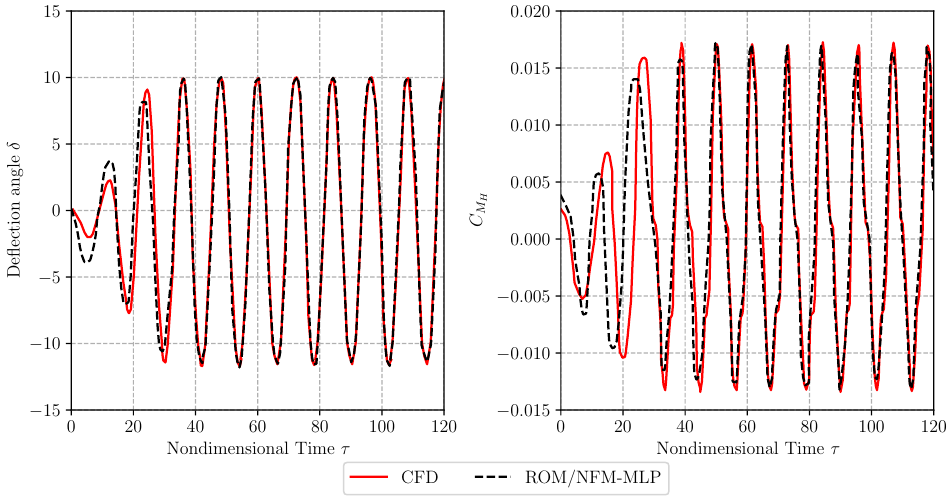
Figure 12. Responses of the resulting aileron deflection angle and hinge moment coefficient at a selected buzz condition (NACA65 1 213 airfoil, Ma ∞ = 0.83, Re = 20.7 the NFM-MLP ROM are compared to the reference CFD solution.